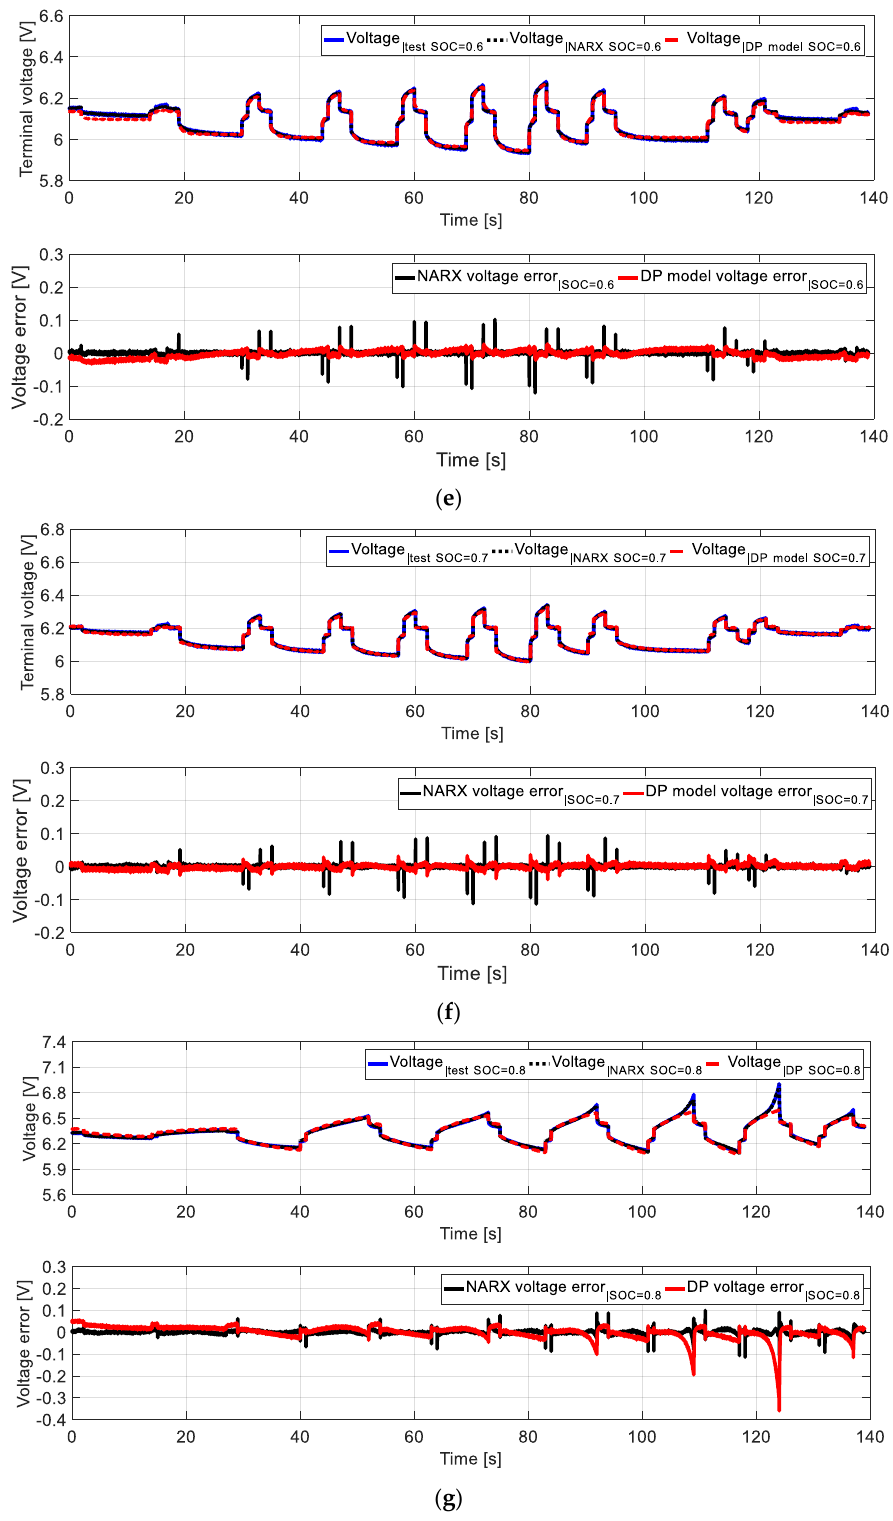
Figure 10. Graphs of voltage at battery terminals. Comparison between NARX and DP models and measurement results, with presented error values, respectively for: ( a ) SOC = 0.2; ( b ) SOC = 0.3; ( c ) SOC = 0.4; ( d ) SOC = 0.5; ( e ) SOC = 0.6; ( f ) SOC = 0.7 and ( g ) SOC = 0.8 in pulse work cycle.